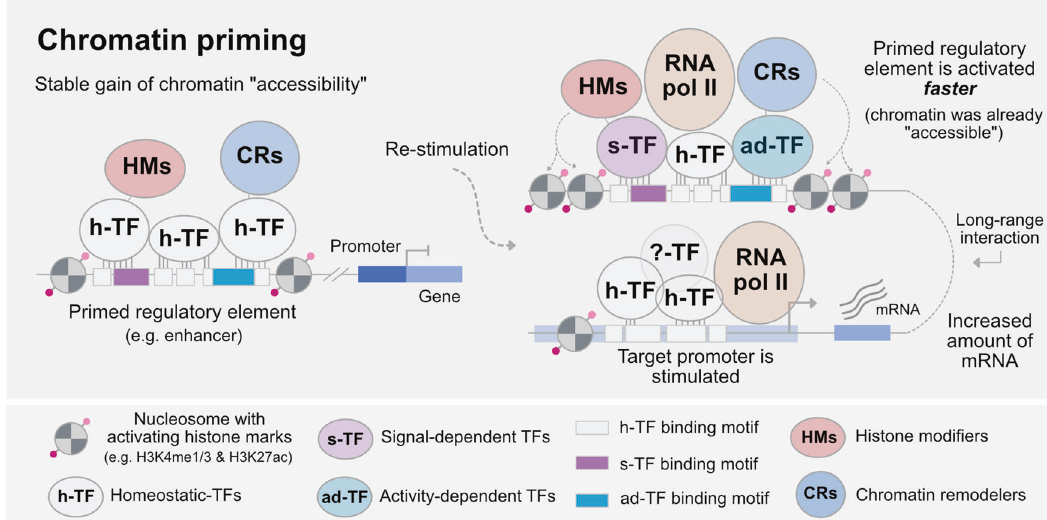
Fig. 2 Model of chromatin priming and its functional consequence for gene expression. Priming of regulatory elements by TFs constitutes a form of chromatin memory for the control of stimulus-dependent gene expression (inspired by fi ndings reported in [10, 101]). Left: primed regulatory element carrying activating histone modi fi cations have a persistent increase in chromatin accessibility and a gain in h-TF, HMs and CRs as a result of previous activity (see Fig. 1, right). Upon re-stimulation, such as neuronal activation or in fl ammation, s-TF and ad-TF can be recruited to the primed regions at a faster rate and likely bind with stronger af fi nity to their target binding sites. A subset of h-TF could also remain associated [101]. The recruitment of s-TF leads to the activation of the primed regulatory element, an enhancer in this case, via recruitment of RNA pol II. The now activated regulatory element can engage in canonical or novel long-range interactions with the promoter of target genes [10] resulting in increased transcription [10, 101]. H3K4me1 and H3K27ac indicated in the fi gure have been associated with priming events in the brain [10, 91] but other histone modi fi cations may contribute to the process. Also, while histone modi fi cations have been associated with priming events, their functional contribution to gene expression has been recently challenged (see main text). The example provided here does not exclude additional functional consequences of chromatin memory in the